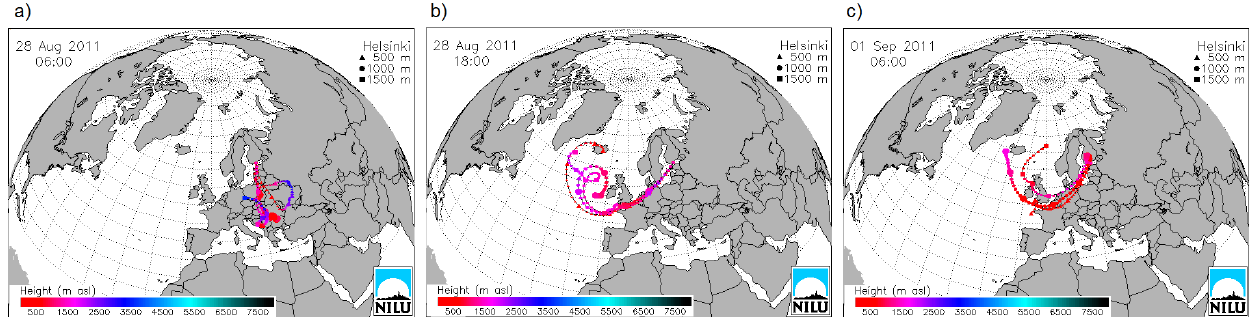
Figure 5. Selected air mass trajectories on 28 August at 06:00UTC (a) and 18:00UTC (b) and on 1 September at 06:00UTC (c) during our campaign in 2011. Please note that the times are given in UTC, whereas our data sets are given in EET (UTC +